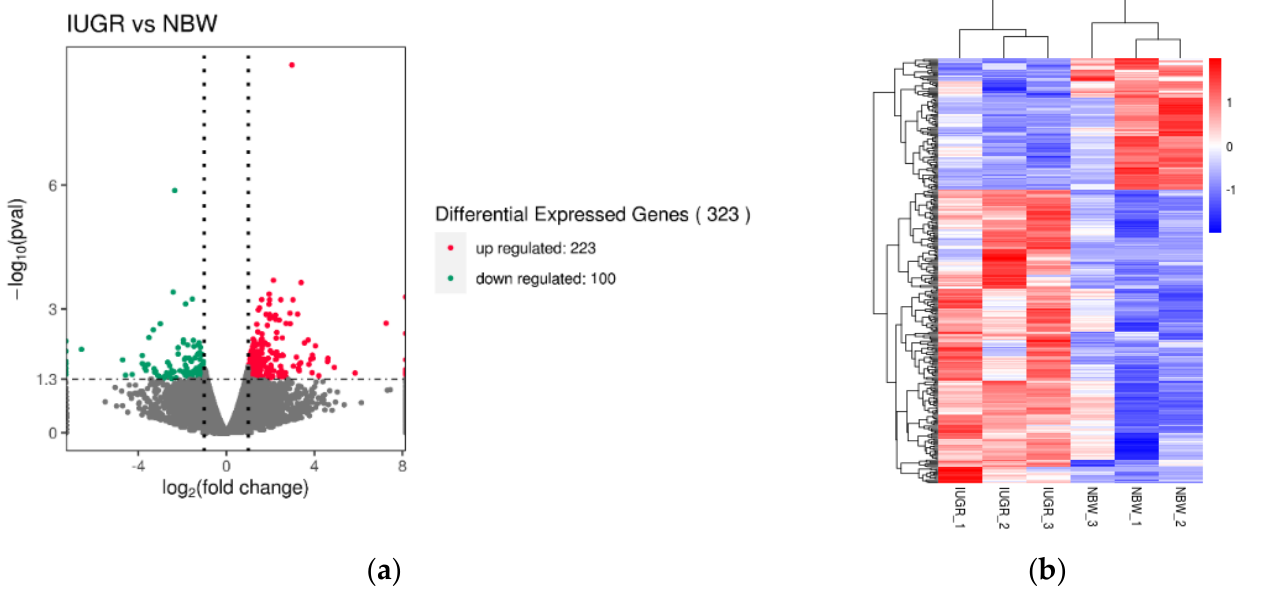
Figure 2 . DEGs Analysis. ( a ) Volcano plot of total expression of genes in both the IUGR and NBW groups. The x -axis represents the log2 (fold-change) values for gene expression, and the y -axis repression the − log10 ( p -value) (padj in the figure represents the p -value; p < 0.05 indicates − log10(padj) > 1.3). ( b ) The color scale represents Fragments Per Kilobase of exon model per Million mapped fragment- (FPKM-) normalized log10 (transformed counts). The horizontal bars represent genes. Each vertical column represents a sample, and sample names are as indicated. Red indicates upregulated genes, while blue indicates downregulated genes. Table 3. Top ten upregulated and top five downregulated in the IUGR group relative to the NBW group.